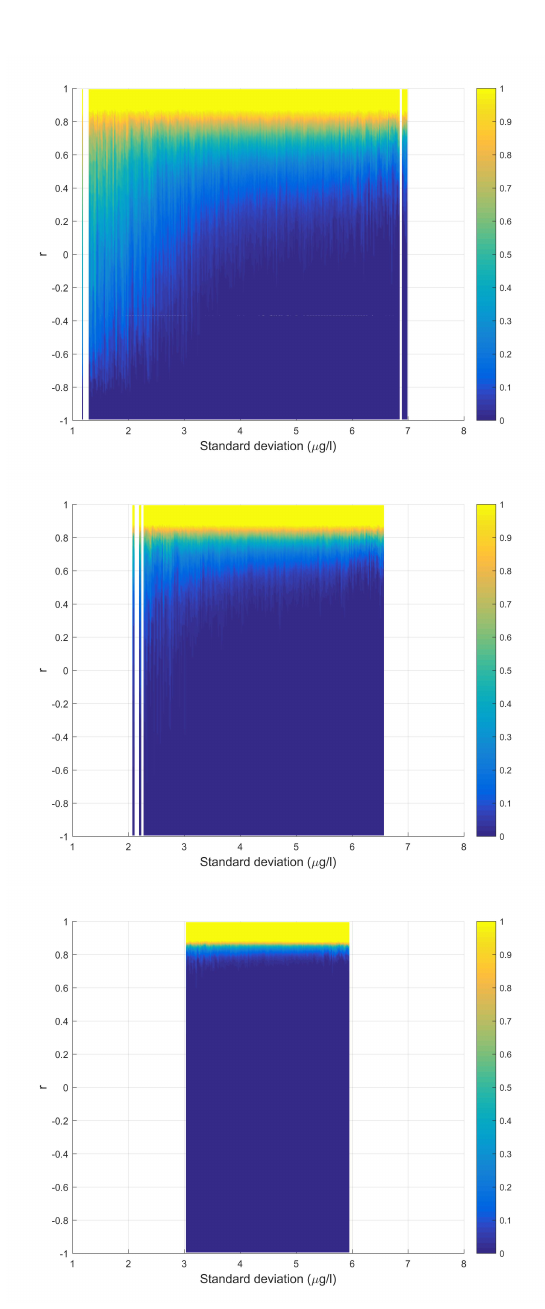
Figure 7. Cumulative probability histograms derived using 5 bands and 8 (top), 12 (middle) and 30 (bottom) randomly selected reference samples. The standard deviation bins for which the sum of counts is below 30 are rejected from probability